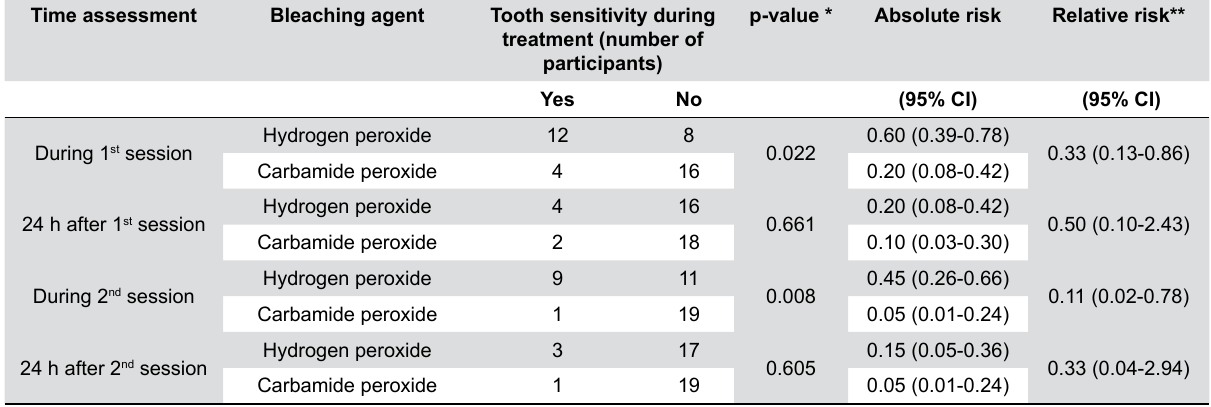
Table 1- Risk of patient-reported tooth sensitivity